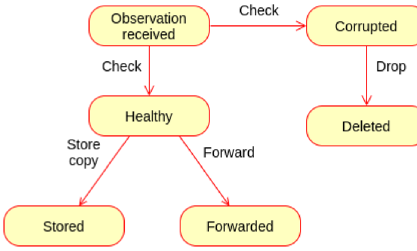
Figure 18. State machine of observation